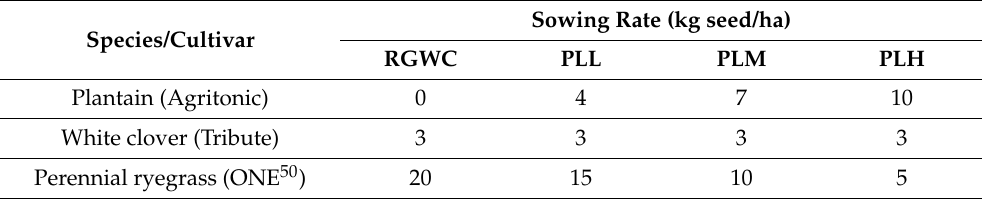
Table 1. Cultivars and sowing rates of perennial ryegrass-white clover (RGWC), RGWC + low plantain rate (PLL), RGWC + medium plantain rate (PLM), and RGWC + high plantain rate (PLH). Sowing Rate (kg seed/ha) Species/Cultivar RGWC PLL PLM PLH Plantain (Agritonic) 0 4 7 10 White clover (Tribute) 3 3 3 3 Perennial ryegrass (ONE 50 ) 20 15 10